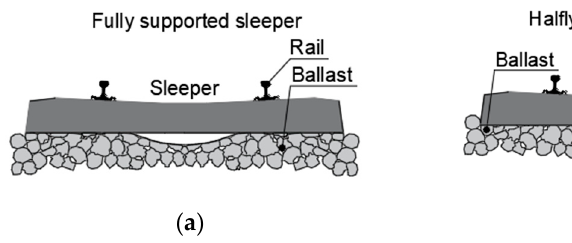
Figure 6. Deterioration of ballasted track under water ponding conditions: ( a ) the softening and movement of subgrade layer and ( b ) the ballast particle rearrangement.